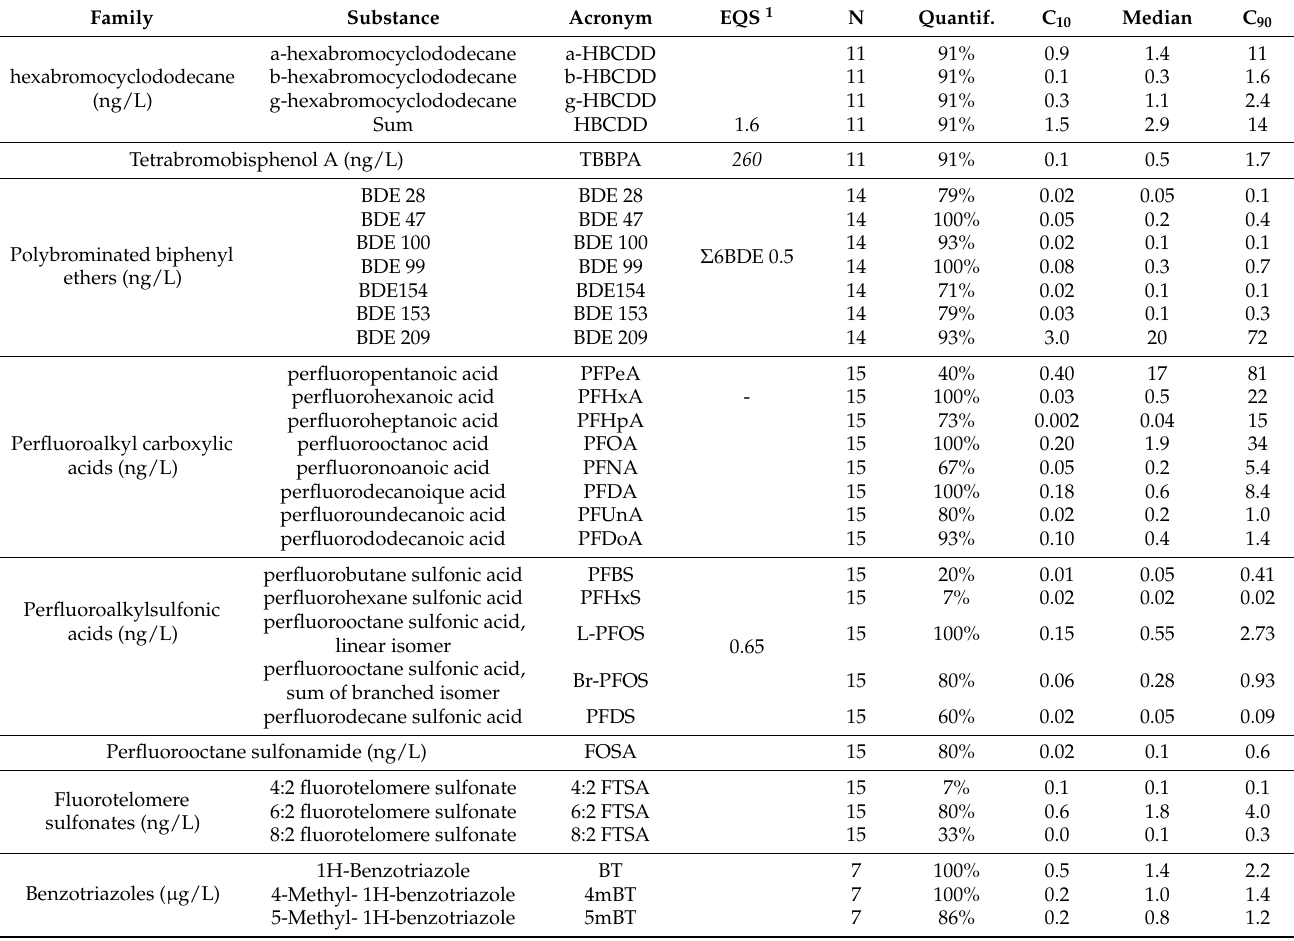
Table 7. Organic micropollutants (groups 4 and 5) analyzed in the runoff, quantification frequency and EMC total